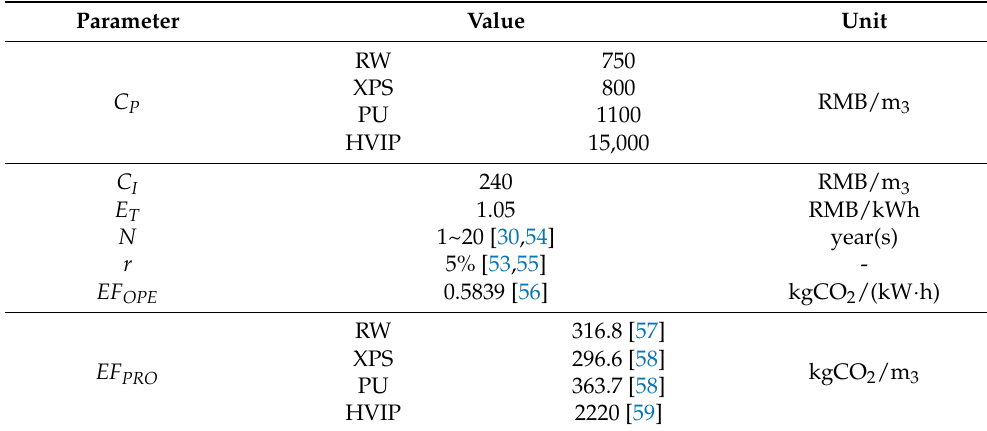
Table 6. Calculation